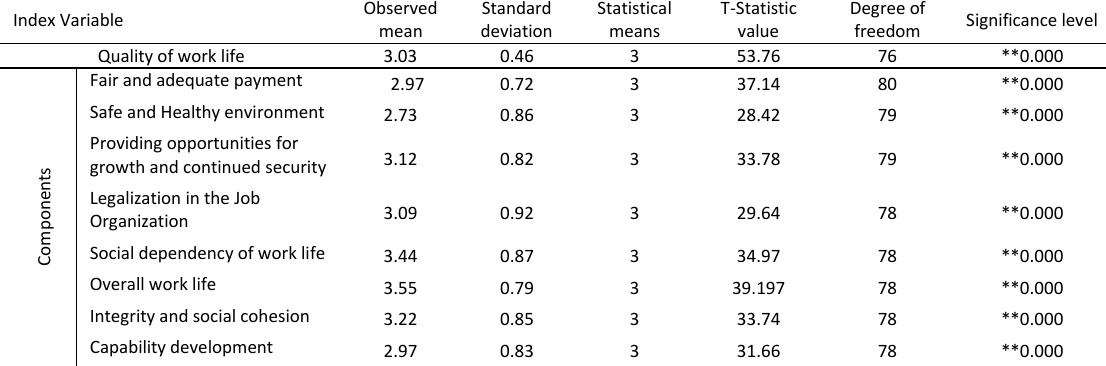
Table 1: Assessment of quality of work life in GDHR from the Perspective of Staffs Using One-Way T-Test Index